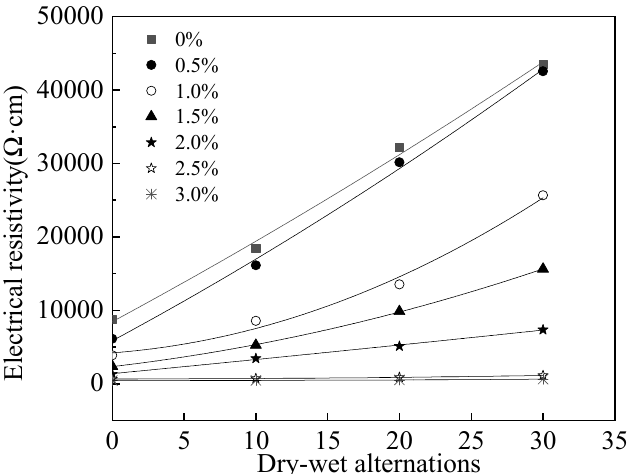
Figure 15. The electrical resistivity of MPC-RPC during NaCl D-W alternations. Table 8. The fitting results of the relationship between ρ and the n .